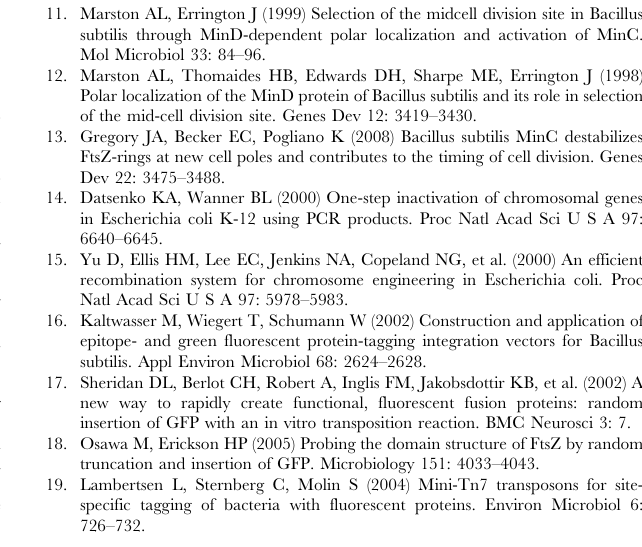
Figure S1 Binding of LacI-GFPi proteins (green) to lacO arrays near ter in growing E. coli cells stained with FM 4–64 (red). Numbers correspond to the codon after which TAGIT was inserted. The complete set of unique insertions is shown